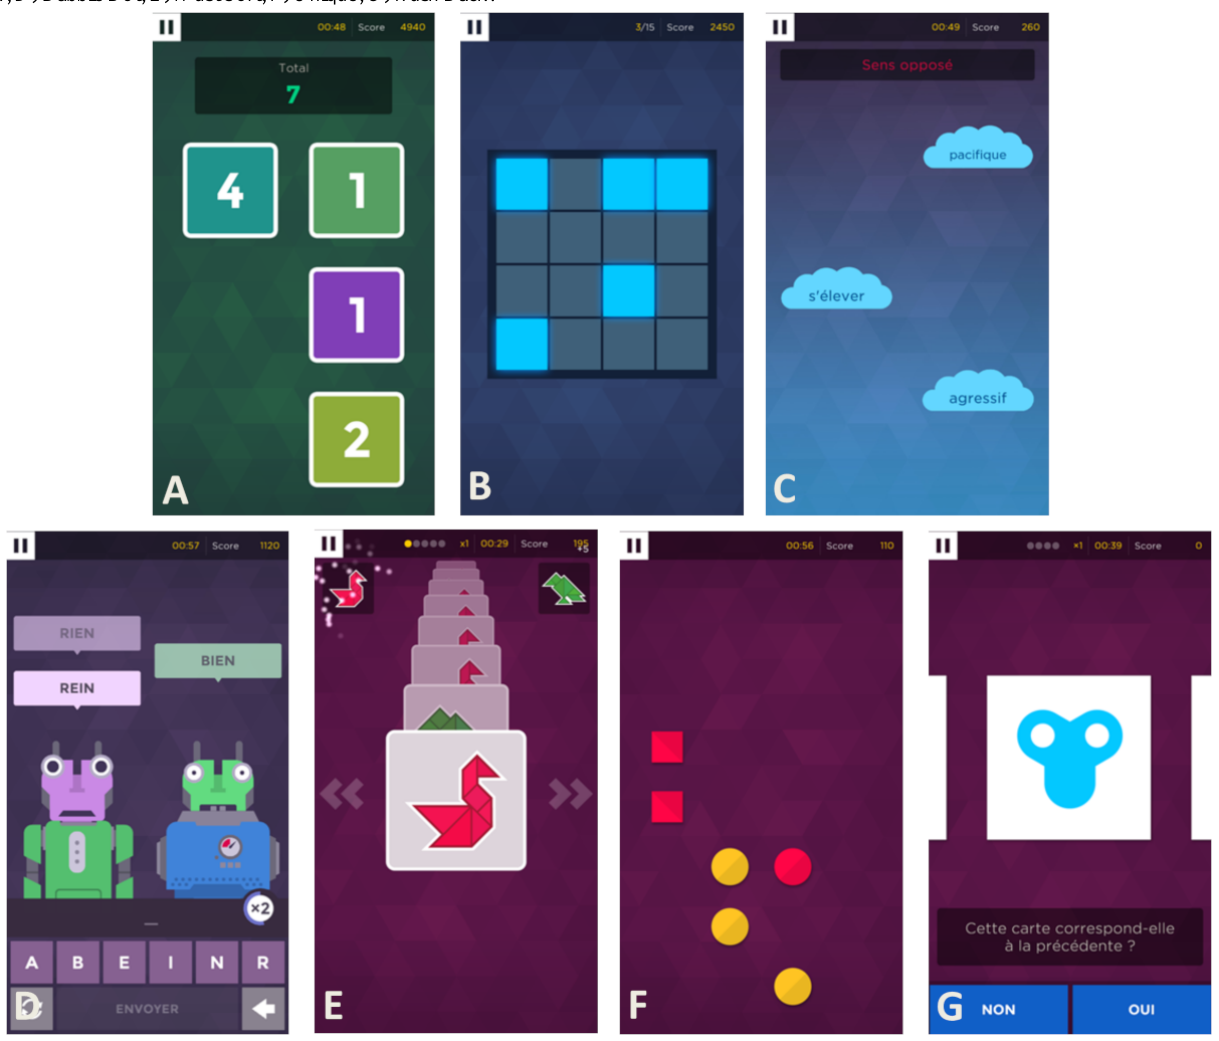
Figure 1. Screenshots of the 7 cognitive mobile games selected for this study from the Peak App. A) Square Numbers, B) Memory Sweep, C) Word Pair, D) Babble Bot, E) Must Sort, F) Unique, G) Rush